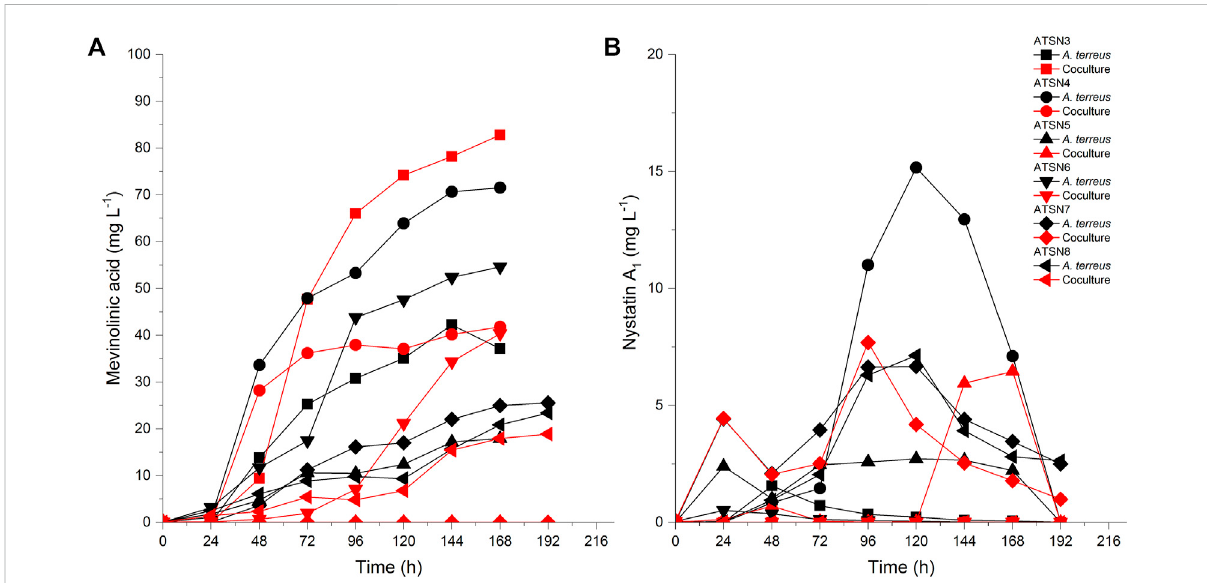
FIGURE 4 Production pro fi les of (A) mevinolinic acid and (B) nystatin A1 under the conditions of mono- and